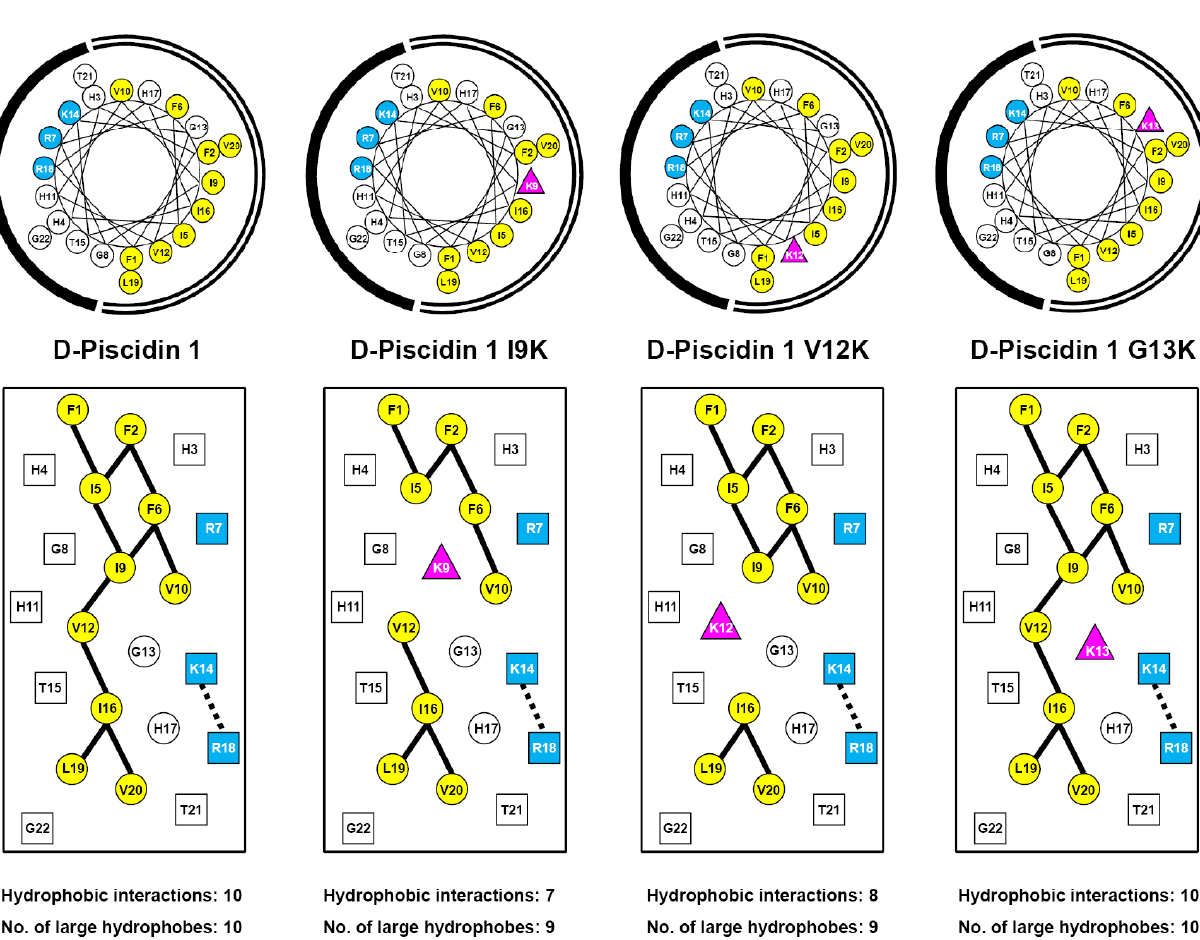
Figure 1. Helical wheel (upper panel) and helical net (lower panel) representation of D -piscidin 1 and analogs are shown in Table 1. The one-letter code is used for amino acid residues. D denotes that all residues in the peptides are in the D -conformation. Positively charged residues (Lys and Arg) are colored blue, large hydrophobic residues (Val, Ile, Leu and Phe) are colored yellow. The ―specificity determinant‖ is denoted by pink triangles. In the helical wheel, the non-polar face is indicated as an open arc and the polar face is shown as a solid arc. In the helical net, the residues on the polar face are boxed and the residues on the non-polar face are circled. The i → i +3 and i → i +4 potential hydrophobic interactions along the helix are shown as black bars. The i → i +4 potential electrostatic repulsions between positively charged residues along the helix are shown as dotted